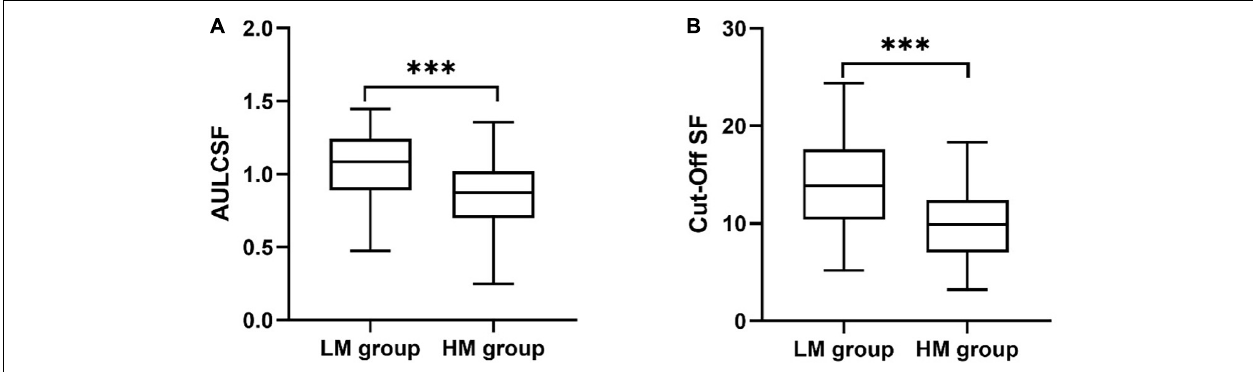
FIGURE 3 | Metrics of the contrast sensitivity function for the sHM and control groups. (A) Area under the log CSF (AULCSF). (B) Cutoff Spatial frequency (Cutoff SF). *** P < 0.001.